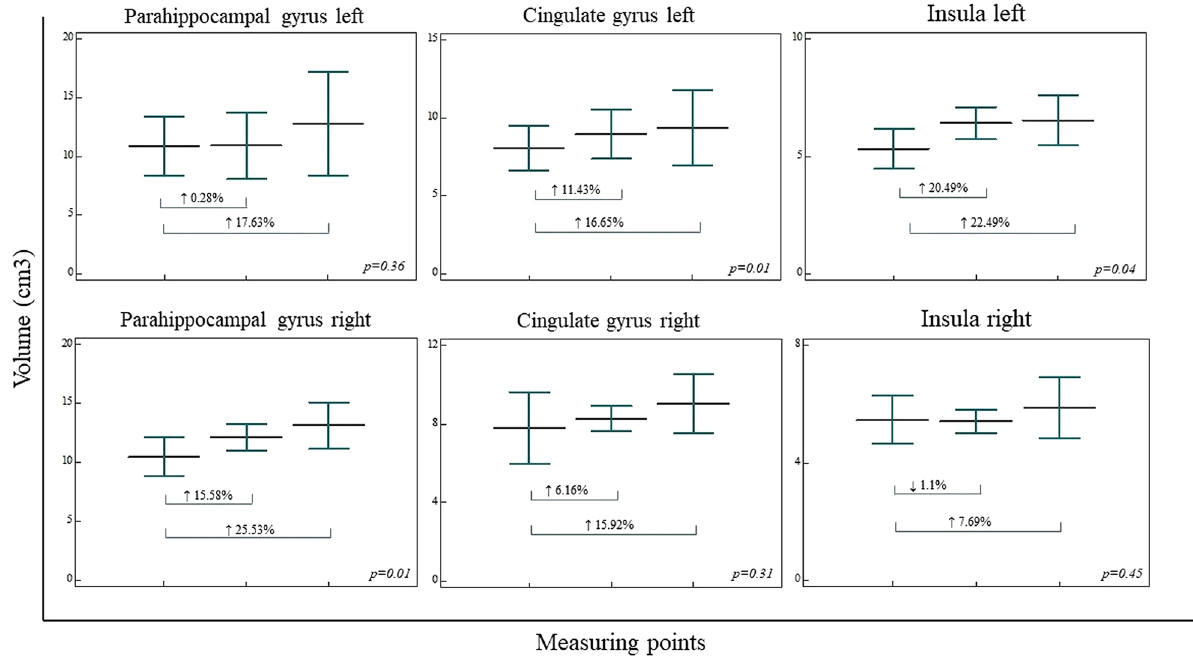
Figure 3. Regional cortical volumetric analysis in three measuring points (prior to DBS, 1 year after DBS, and 7 years after DBS). The regional cortical volumetric analysis revealed significant volume increase in right parahippocampal gyrus, left cingulate gyrus, and left insula, while the trend of volume increase was presented in left parahippocampal gyrus volume, right cingulate gyrus volume, and right insula volume. Vertical bars, standard deviation .